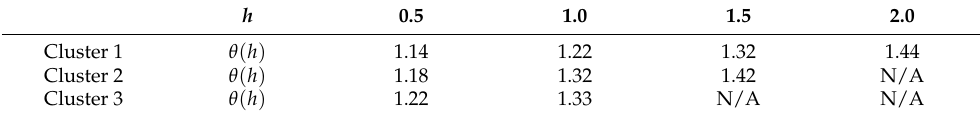
Table 9. Estimation of the extremal index for the precipitation data.